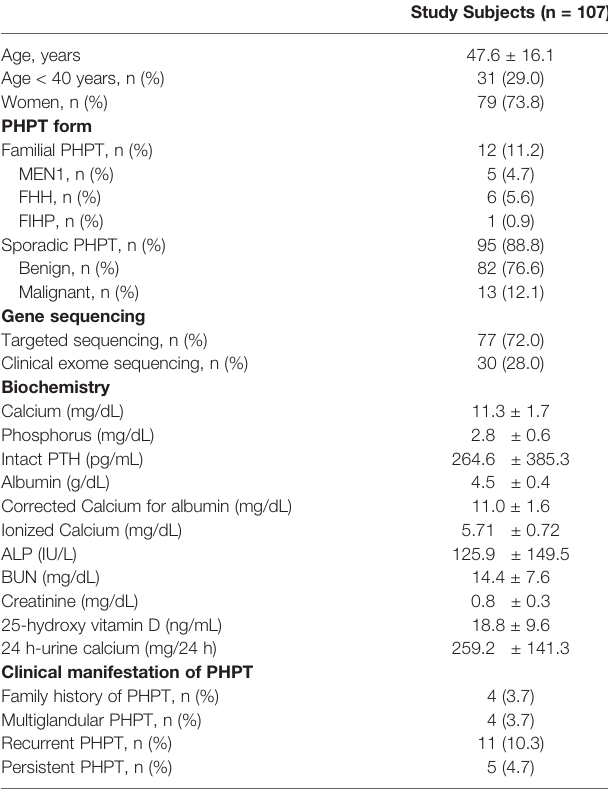
TABLE 1 | Baseline characteristics of study